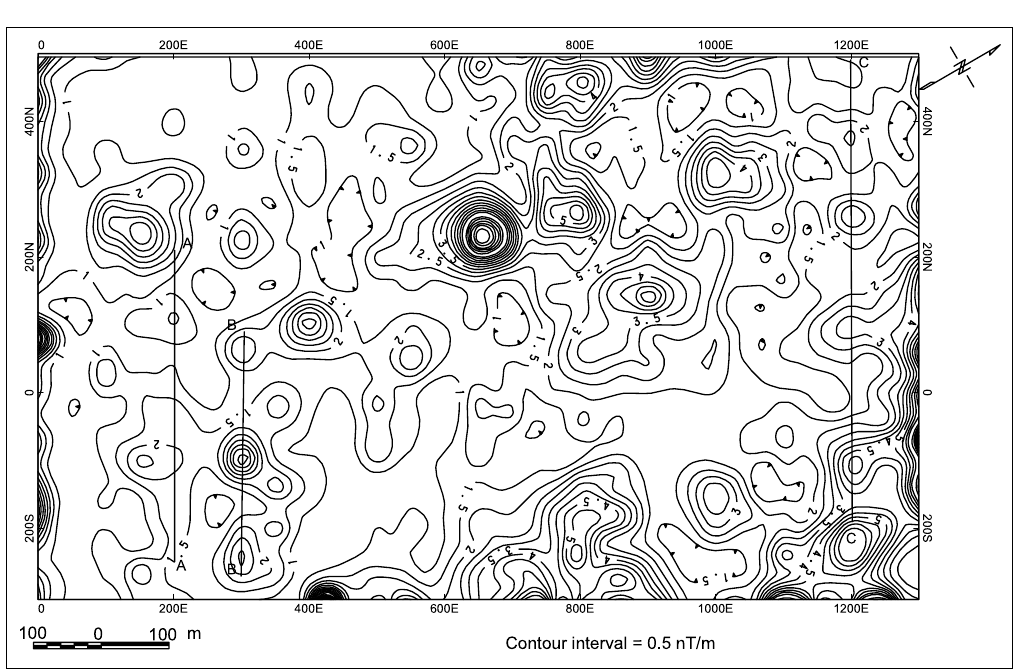
Fig. 4. Analytic signal of the total intensity magnetic map of the Abu-Shihat radioactive prospect area, North Eastern Desert,